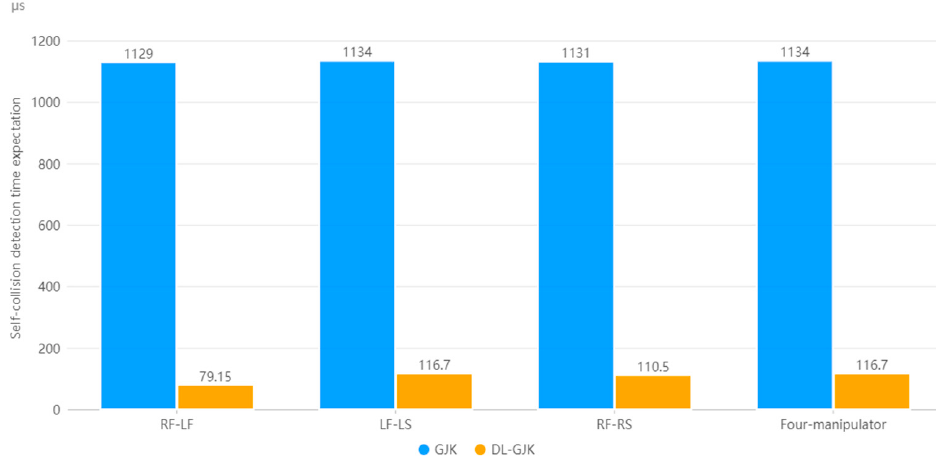
Figure 17. Single-detection time expectation of system workspace.